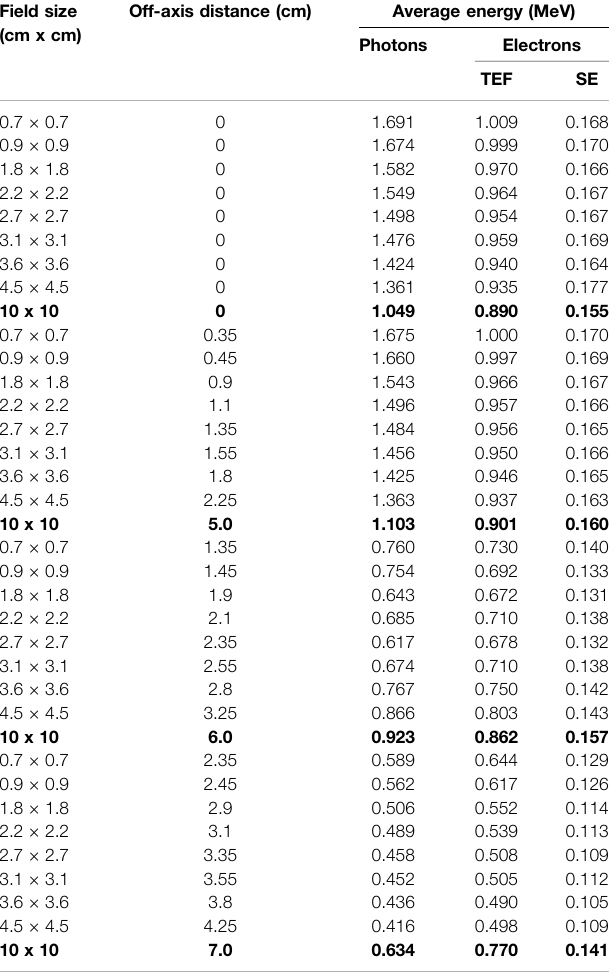
TABLE 4 | Mean photon and electron (TEF and SE) energy at water depth (cid:2) 9.85 cm. The uncertainties are 0.1 – 0.7% (coverage factor, k (cid:2) 1 ) [27]. Field size Off-axis distance (cm) (cm x cm)